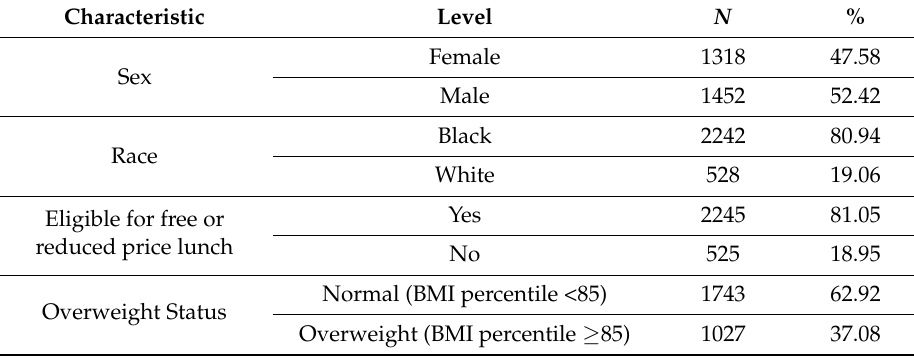
Table 1. Child characteristics, Spring 2010 (Total N = 2770).